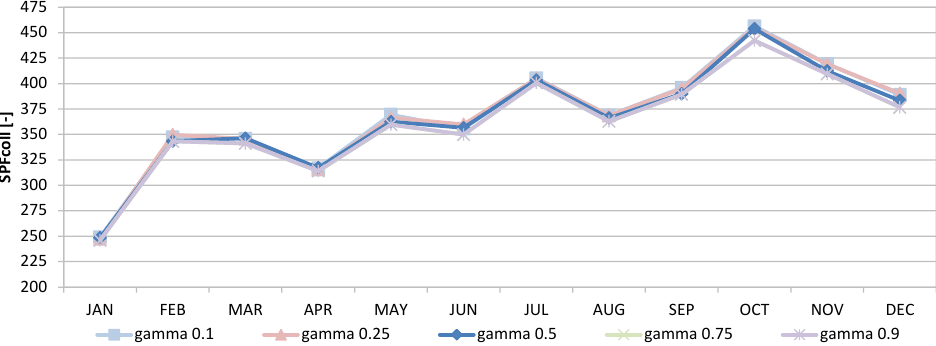
ff erent parameters gamma.